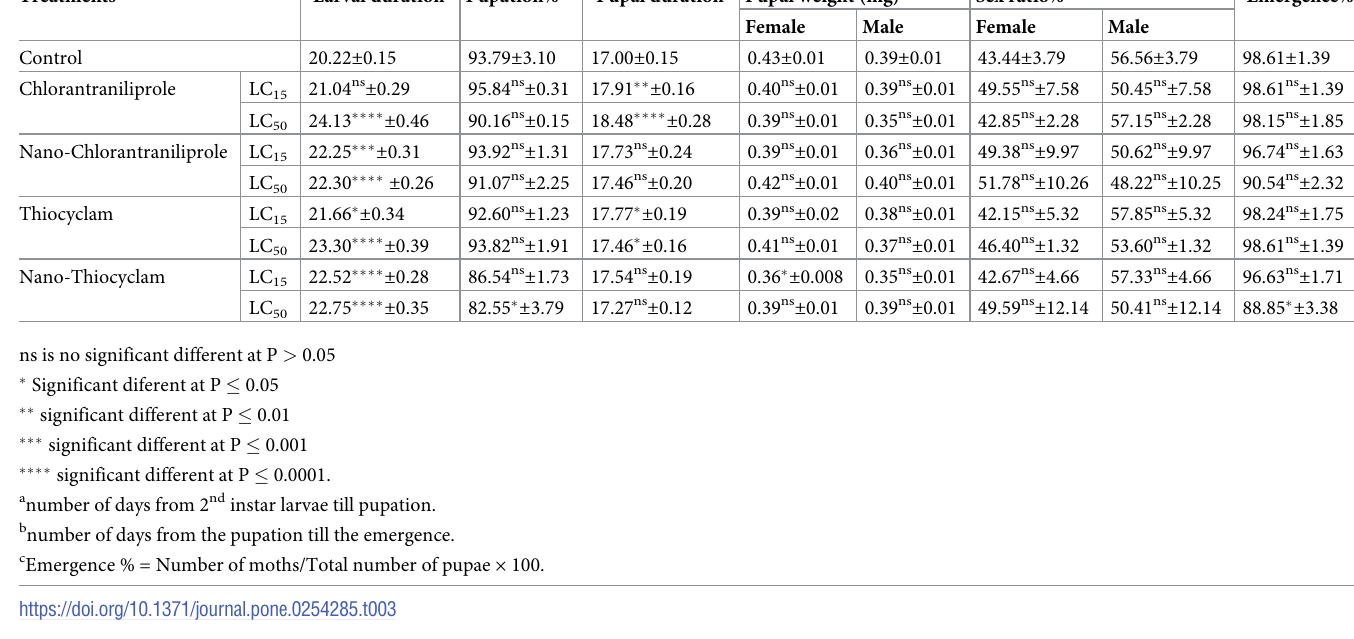
Table 3. Effects of chlorantraniliprole, thiocyclam, and their nano-form in the developmental stages of A . ipsilon .